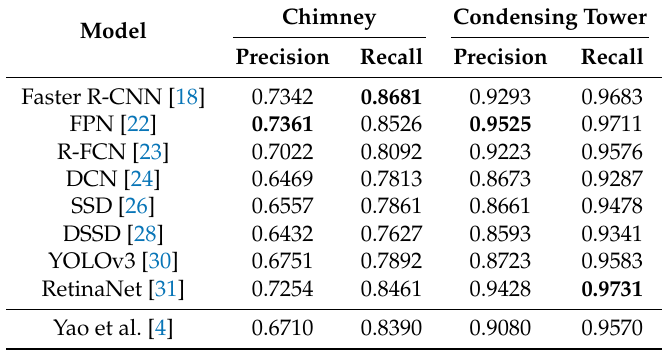
Table 4. Precision and recall of eight models for power plant detection and the comparison with [4]. The bold font indicates the best